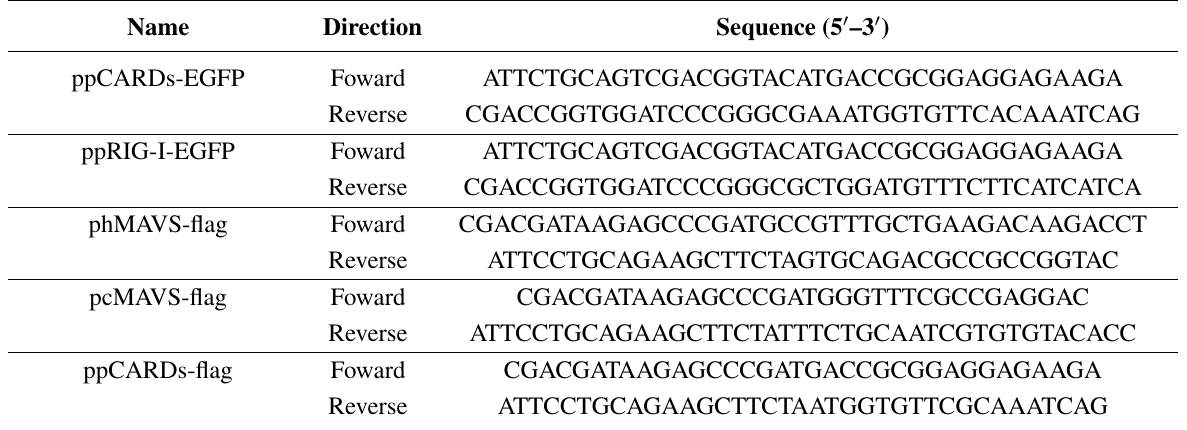
Table 1. Primers list for homologous